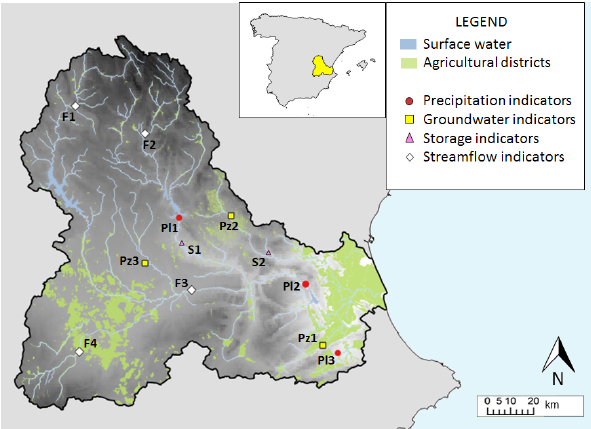
Figure 4. Map of the Jucar river basin network. The colored mark- ers represent the variables considered for the state index